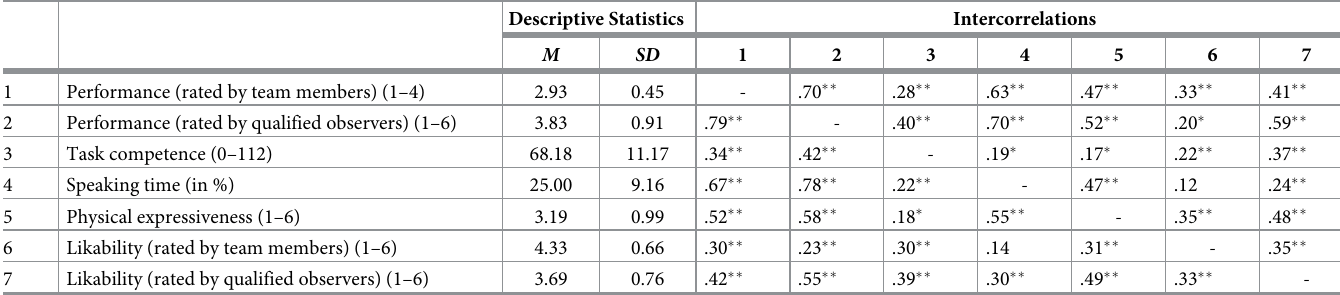
Table 1. Descriptive statistics and